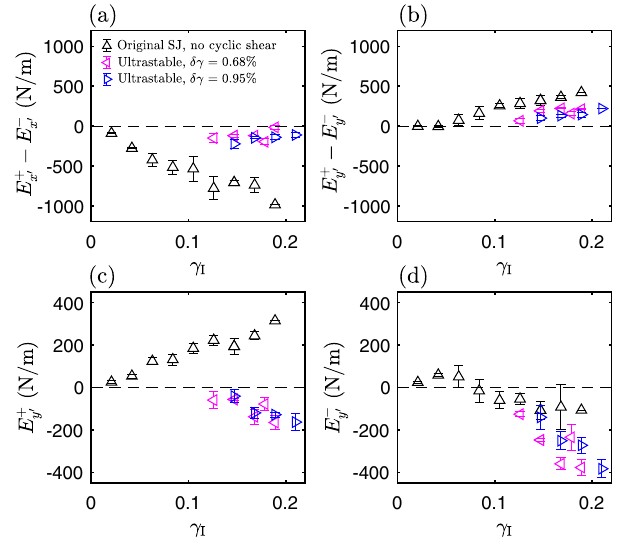
(a).FIG. 3. Measuring the slopes E þ , E − , E þ , and E − near the FIG. 4. (a),(b) The differences between the slopes E x 0 y 0 x 0 y 0 states of interest from the stress-strain curves. The stresses σ measured under the forward shear (denoted by the superscript þ ) x 0 x 0 and σ are stress tensor elements in the coordinate system x 0 y 0 and under the reverse shear (denoted by the superscript − ) for the y 0 y 0 rotated π = 4 from the original coordinate system xy as shown in original SJ states and the ultrastable states. (c),(d) The slopes E þ Fig. 1(a). The x 0 and y 0 directions are the principal compression and E − for the states of interest. The legend in (a) applies also for y 0 and dilation directions of the forward shear where γ increases, (b) – (d). In (a) – (d), the horizontal axis is the initial shear strain γ and they become the principal dilation and compression direc- used to prepare the original SJ and the ultrastable states. The tions during reverse shearing where γ decreases, as highlighted by cyclic strain amplitudes used to prepare the ultrastable states are the two sketches in (a). (a) and (c) plot the data measured during given by the legend in the initial shear and reverse shear near an example original shear-jammed (SJ) state formed by an initial shear with γ ¼ 0 . 147 . The gray arrows mark the shearing directions. I (b) and (d) plot an example ultrastable state formed by applying cyclic shear with strain amplitude δγ ¼ 0 . 95% on an original SJ ¼ 0 . 21 . In (b) and (d), filled state formed by an initial shear γ I triangles are data measured in the last shear cycle, and the open triangles are data measured in the reverse shearing process that follows [see Fig. 1(b)]. The light blue data are those not used in calculating the slopes of interest. The arrows in (b) and (d) mark the shearing directions. In (a) – (d), the original SJ state and the ultrastable state near which the slopes are measured are highlighted by the dashed black